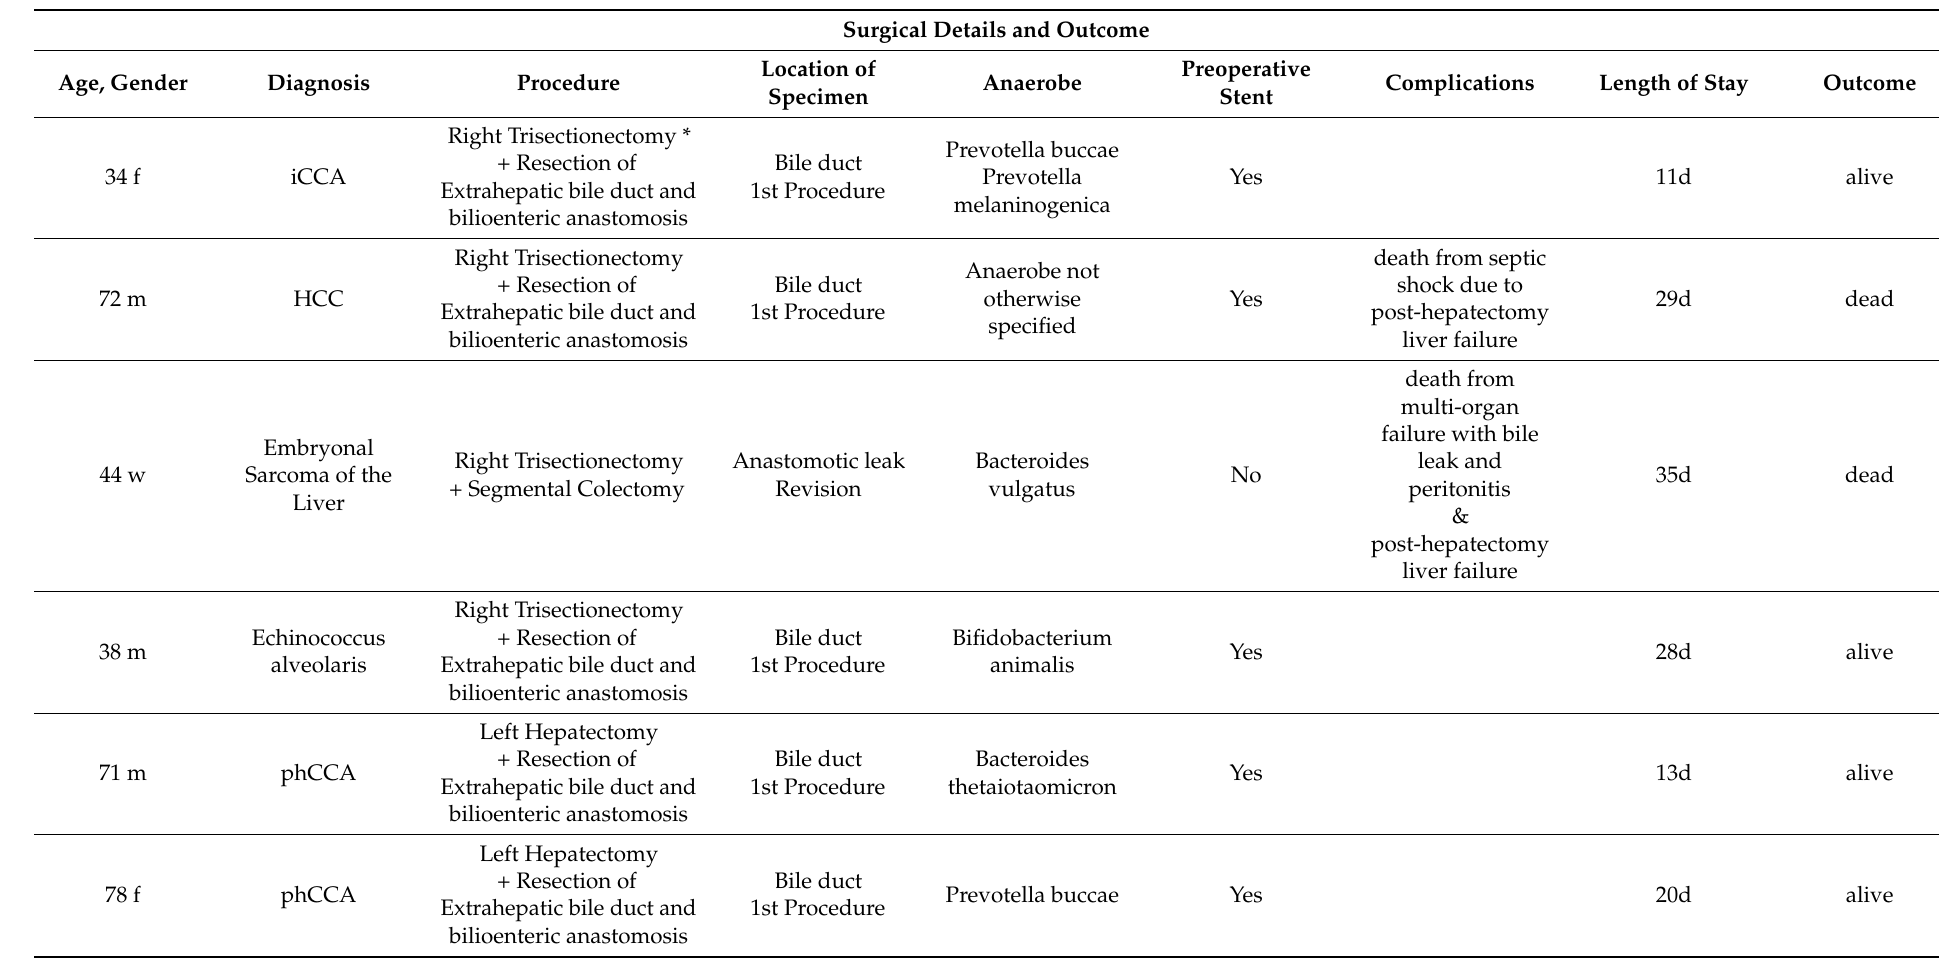
Table 1. The surgical procedures and outcomes, as well as the isolated anaerobic strains of the 13 patients that had positive anaerobic cultures. * Procedures according to Brisbane